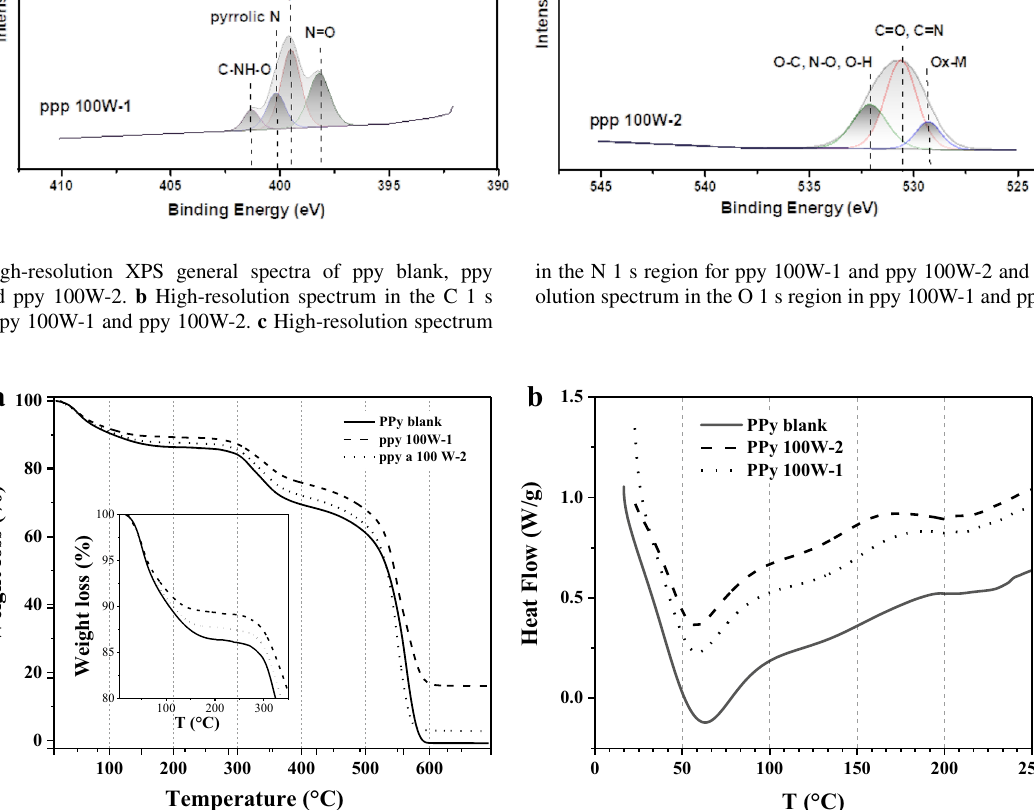
Fig. 5 TGA curves of ppy blank, ppy 100W-1 and ppy 100W-2 measured under nitrogen